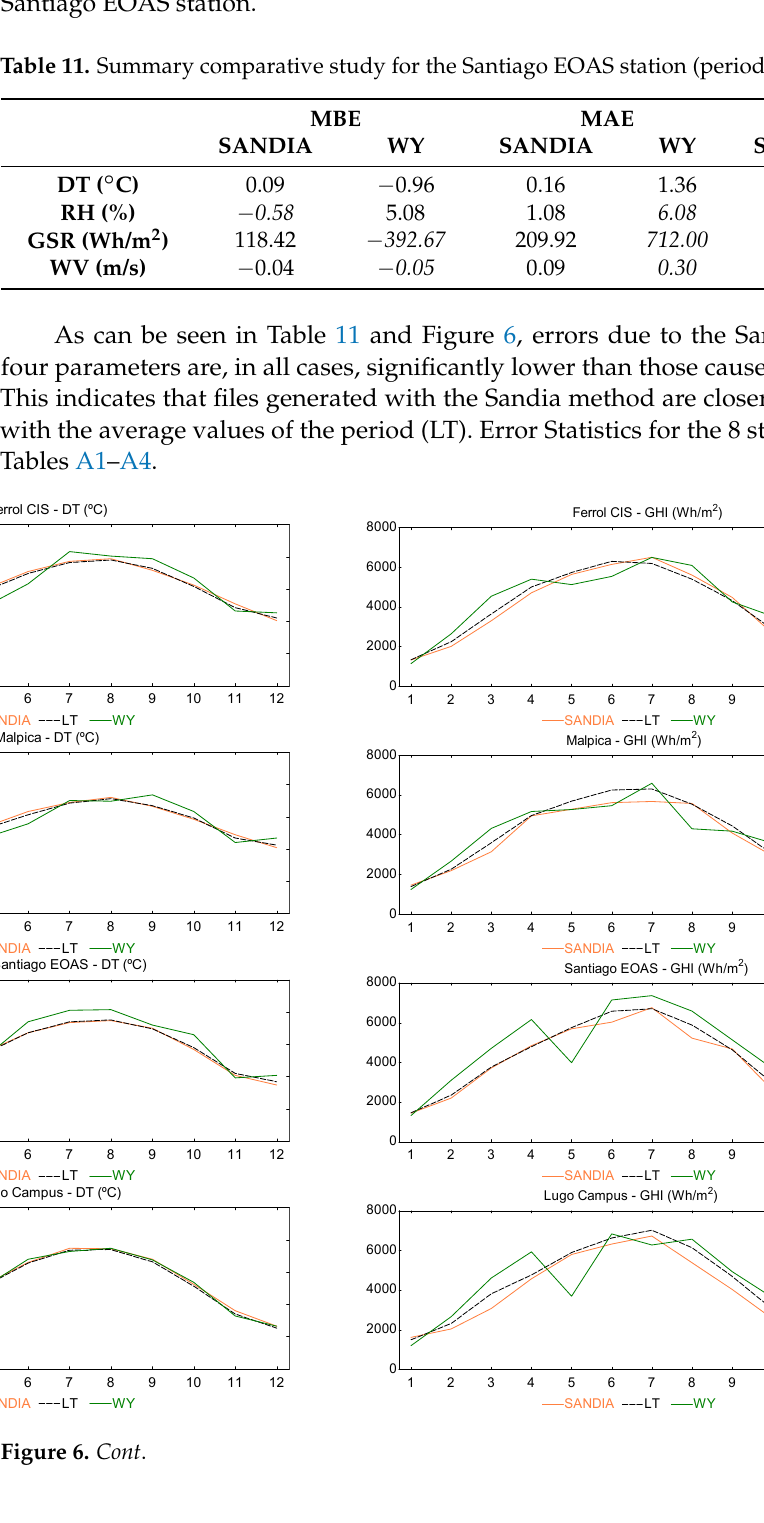
Table 11 shows as an example the Errors for the parameters: Dry Temperature, Rela- Table 11. Summary comparative study for the Santiago EOAS station (period 2008–2017).